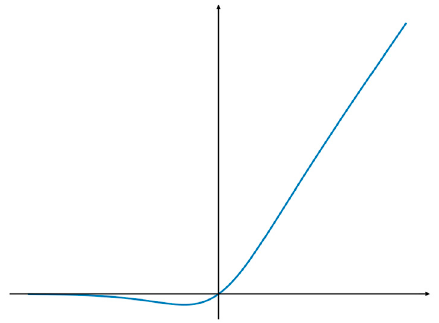
Figure 5. SiLU activation function structure diagram. Table 1. Comparison of number of layers, parameters, and calculation in the YOLOv5s improve- ment process.